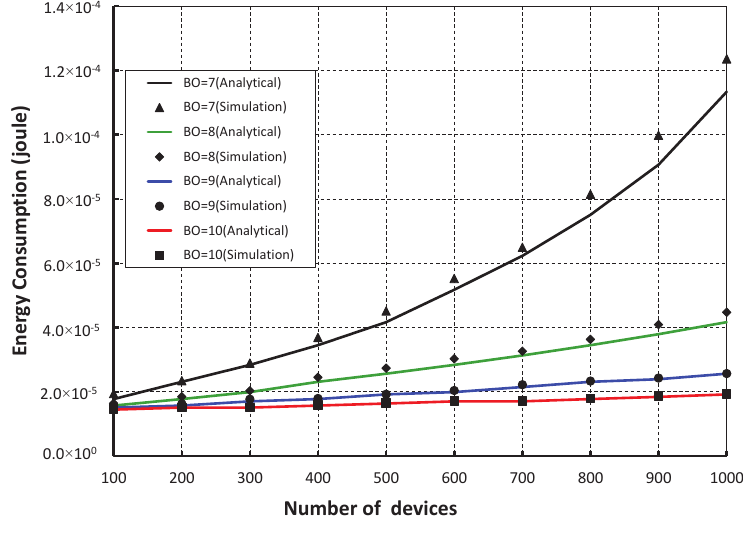
Figure 16. Validation of energy consumption for different beacon